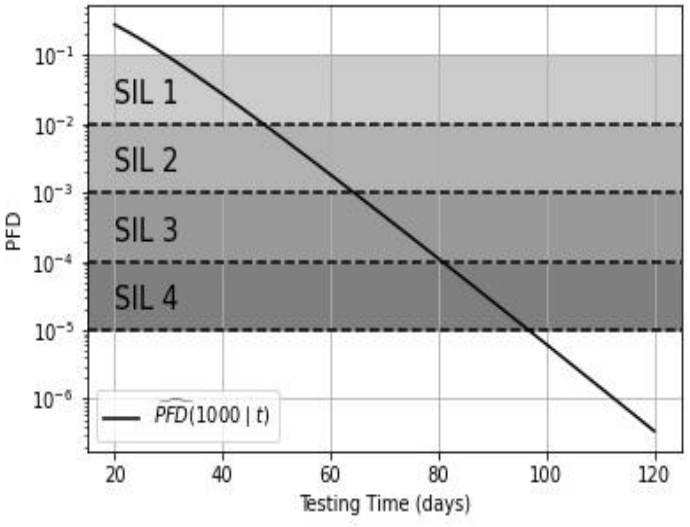
Figure 3. Estimated target failure measures of PFD.